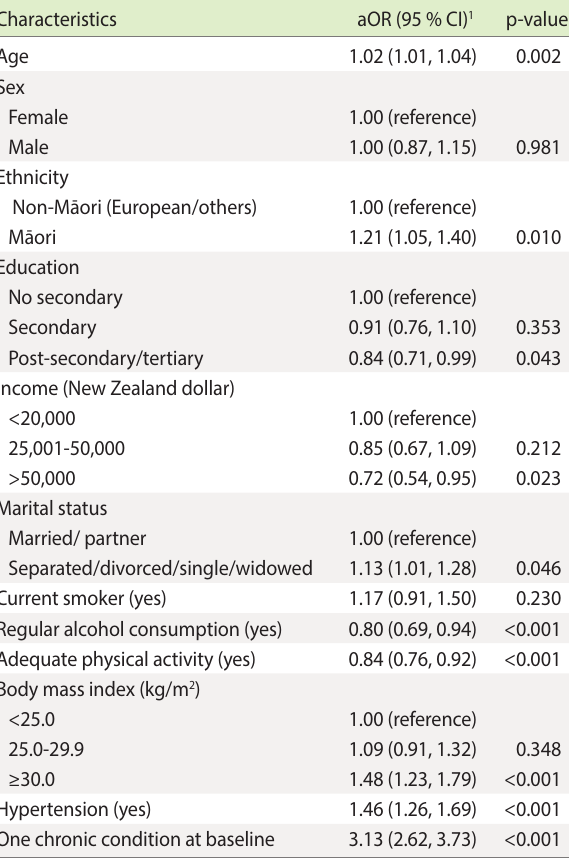
Table 2. Predictors of the incidence of multimorbidity among